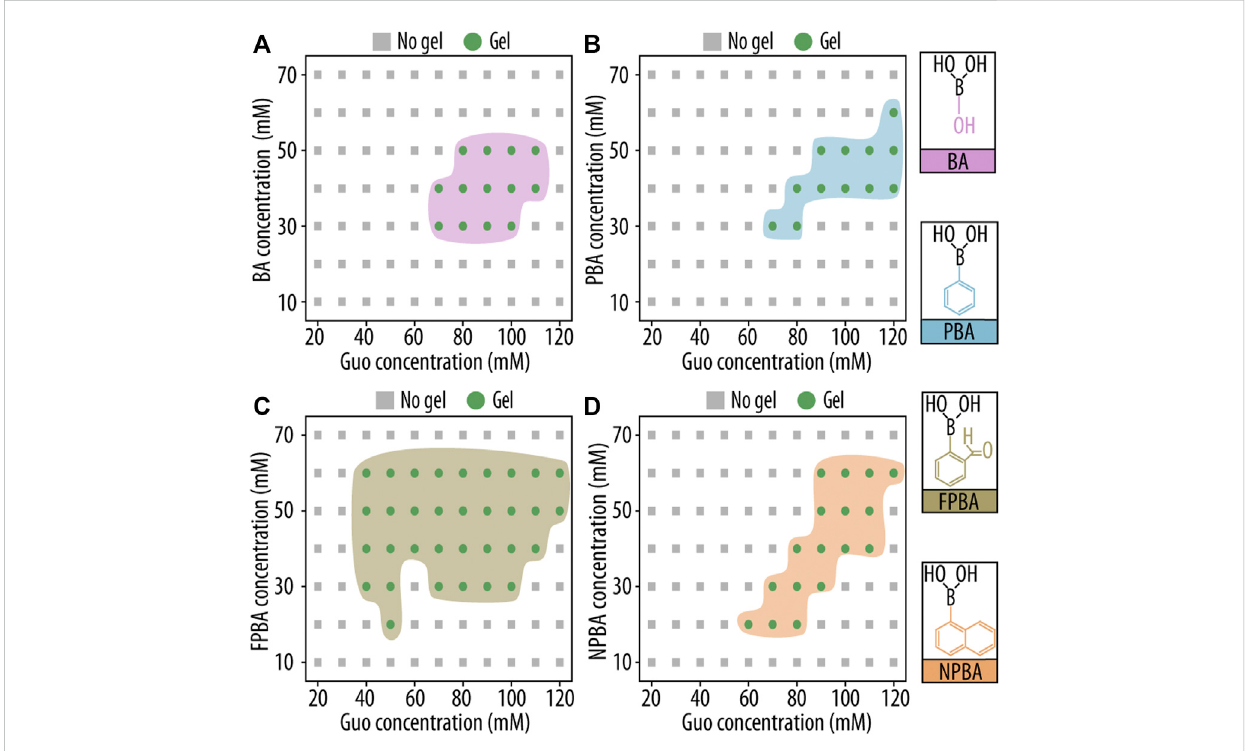
FIGURE 2 Gelation study of guanosine (Guo)-based hydrogels with boric acid derivatives (GB hydrogels) using a vial inversion test. Phase diagrams of gelation after 1 h at room temperature (RT) are shown as functions of Guo concentration and (A) boric acid (BA), (B) phenyl boronic acid (PBA), (C) 2- formilphenylboronic acid (FPBA), and (D) 2-naphtylboronic acid (NPBA)